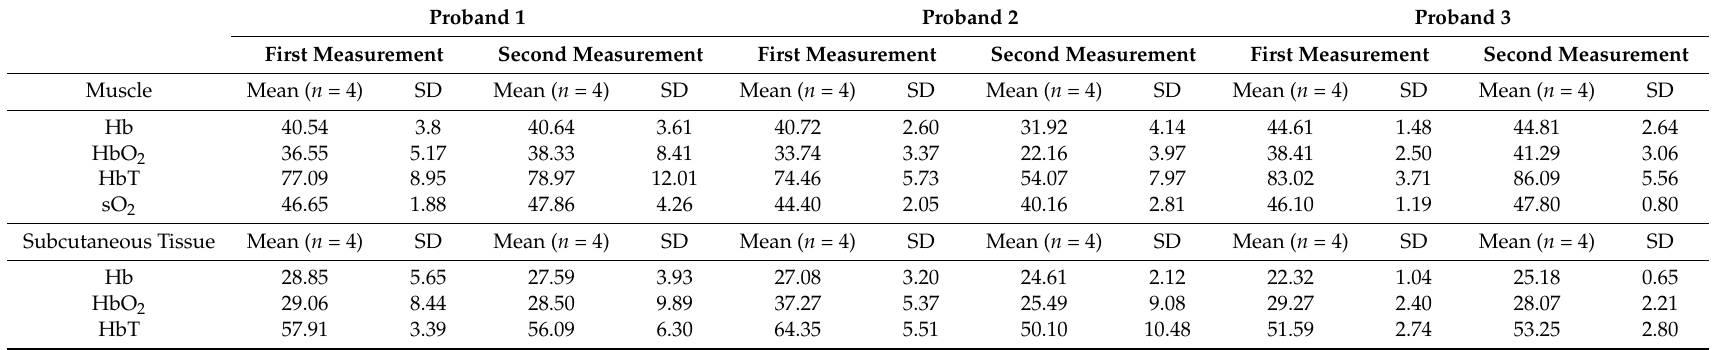
Table 2. Intrarater variability of calculated MSOT values (a.u.): Comparison of first and second measurement acquired by the same examiner investigating three different